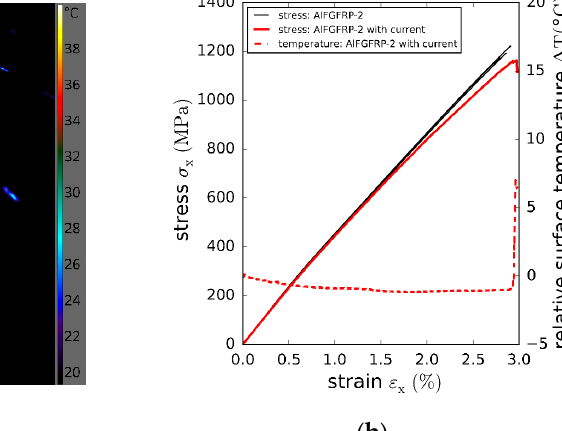
Figure 25. SN curves of AlFGFRP-2 with regression curves and prediction bands: sole mechanical fatigue loads (green) and combined electro-mechanical loading with a constant current of 10 A (red).